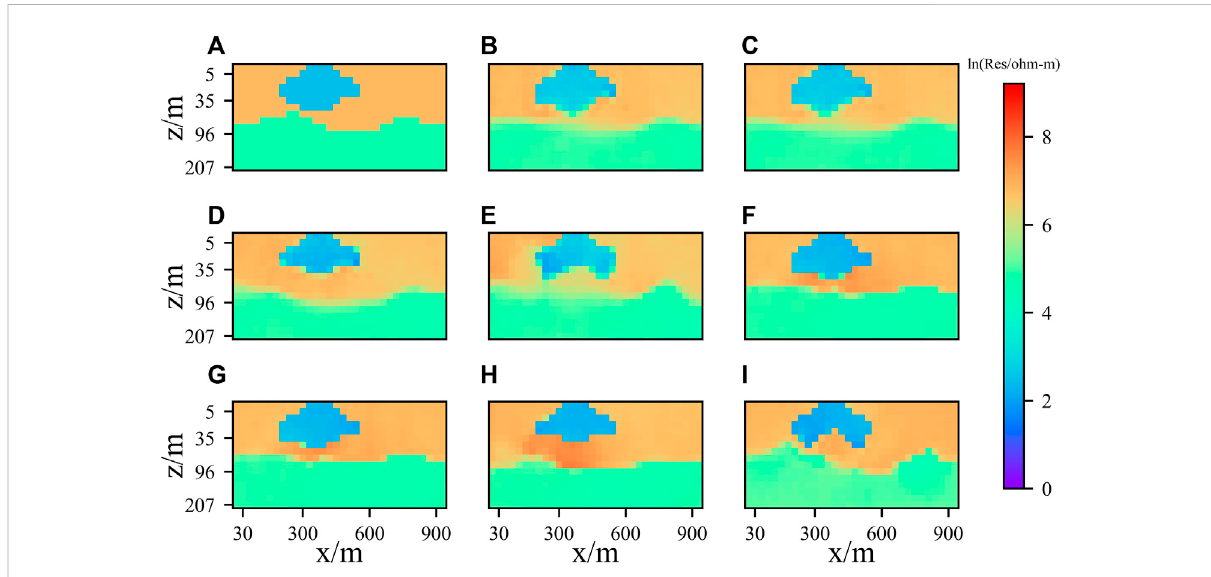
Imagingresultswithdifferenttrainingepochsfordatawithdifferentlevelsofnoise. (A) Truemodel (B – E) imagingresultswith50trainingepochs for the noise level of 0%, 1%, 5%, and 10% (F – I) imaging results with 200 training epochs for the noise level of 0%, 1%, 5%, and 10%,